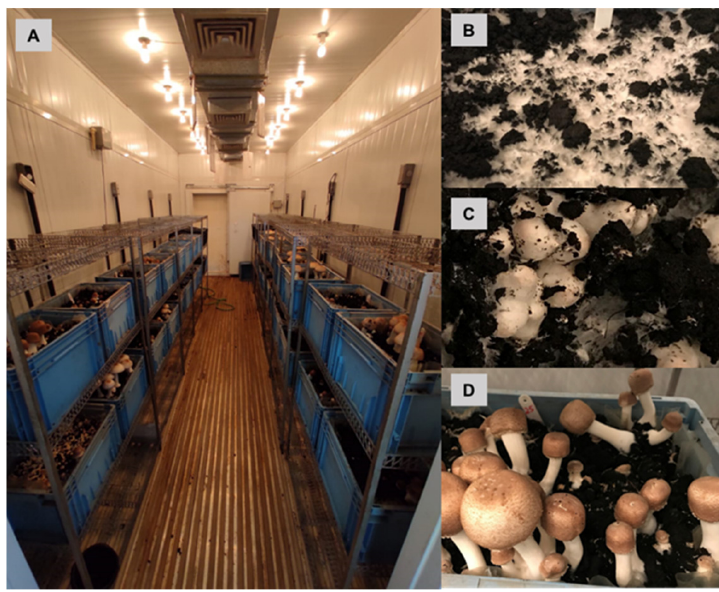
Figure 2. Agaricus subrufescens produced in a controlled environment: ( A ) specific climatic chamber for mushroom production; ( B ) mycelium development in peat moss; ( C ) formation of beginnings; ( D ) mushrooms in the harvest phase.